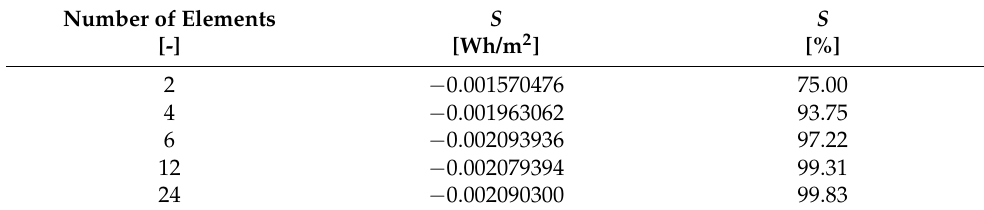
Table 3. Dependence of accuracy on the number of elements.